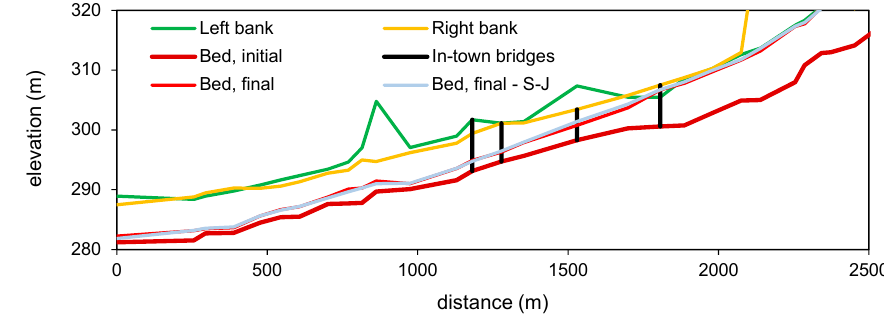
Figure 17. Model of the design flood scenario: sensitivity to the sediment transport formula (S ‐ J = equation by [36]).